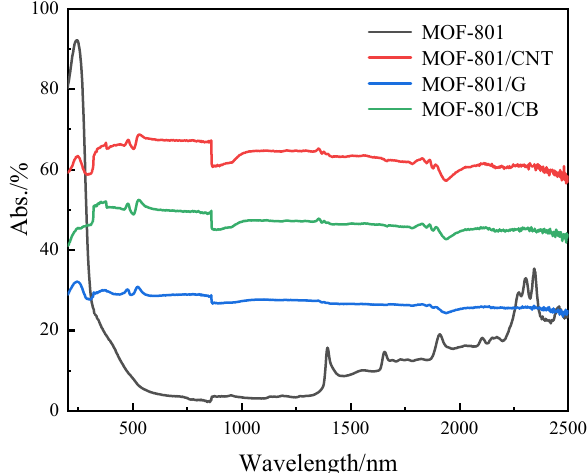
Figure 8. The light absorption curves of MOF-801, MOF-801/CNT, MOF-801/G, and MOF-801/CB.